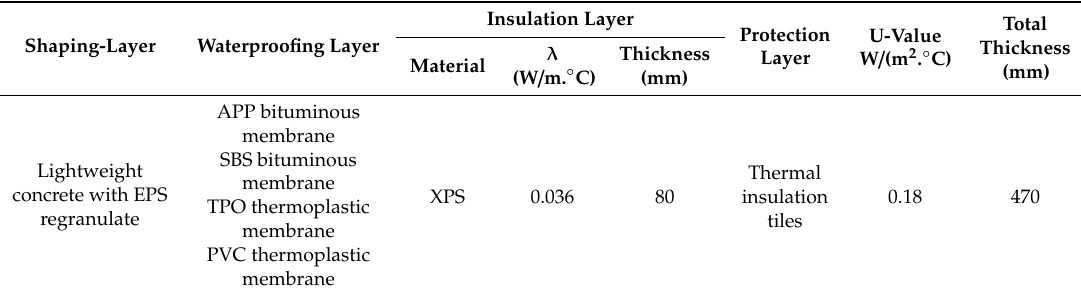
Table 6. Example of different flat roofs solutions (with thermal insulation tiles) studied in a complementary research to assess the environmental, economic and energy performance of 114 flat roofs solutions (i.e., solutions for inverted flat roofs accessible to people)